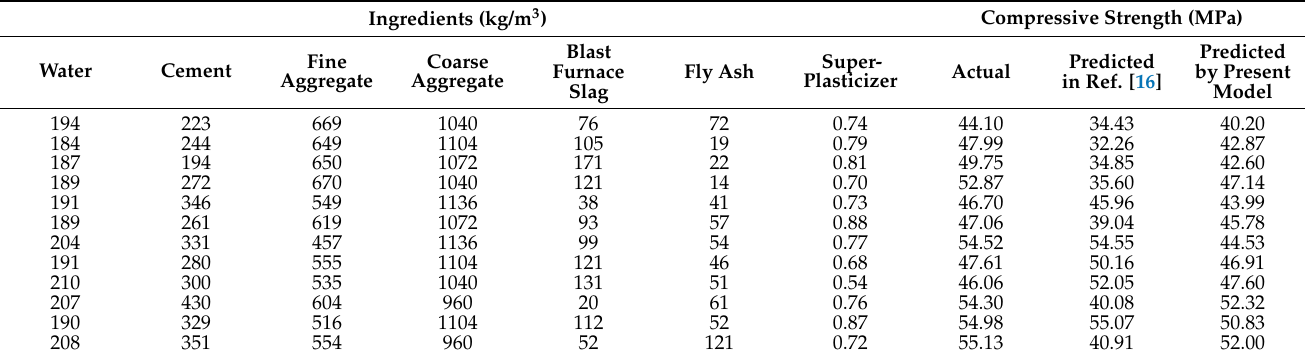
range of the compressive strength in the database is from 5.66 to 95.3 MPa. It is found in Figure 4 that the circular dots are more focused to the central inclined line. This implies that our ANN model outperforms the ANN model of [16] in the verification. Table 4. The predicted and actual compressive strengths of the experimental concrete mixtures in